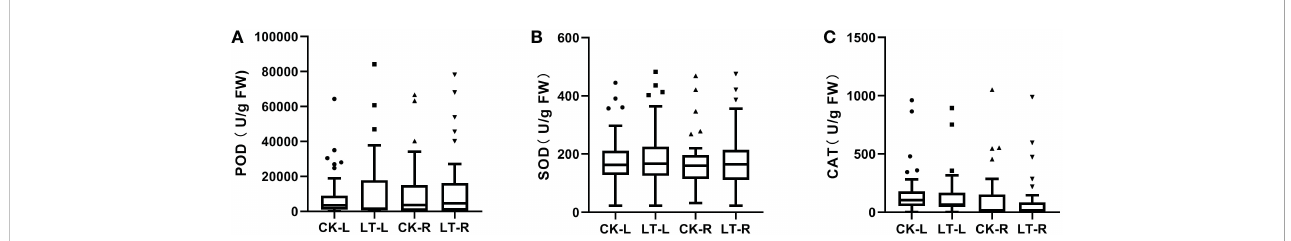
FIGURE 1 The levels of reactive oxygen scavengers signi fi cantly different among cassava genotypes during low temperature-induced leaf abscission. (A – C) Peroxidase (POD) (A) , Superoxide dismutase (SOD) (B) and Catalase (CAT) (C) activities in cassava were detected among cassava genotypes during low temperature-induced leaf abscission. CK-L: Leaf control; LT-L: Leaf treated at 4°C for 24 hours; CK-R: root control; LT-R: root treated at 4°C for 24 hours. In low temperature-induced cassava leaf abscission, signi fi cant differences in reactive oxygen species scavengers were detected between cassava genotypes. Cassava grown for 120 days was selected as the experimental material. The cassava plants with consistent growth were selected for low-temperature treatment. After the plants were treated at 4°C for 24 hours, the control plants were placed in the greenhouse for normal growth. The treated and control plants were placed in the greenhouse simultaneously for growth recovery. Samples were taken after 10 days of growth recovery. The leaves were collected from the upper, middle, and lower parts of the four plants. The roots of the four plants were mixed and frozen in liquid nitrogen and stored at − 80°C. During low temperature-induced leaf abscission, POD, SOD and CAT activities in cassava were detected. The value is represented as mean ± standard error